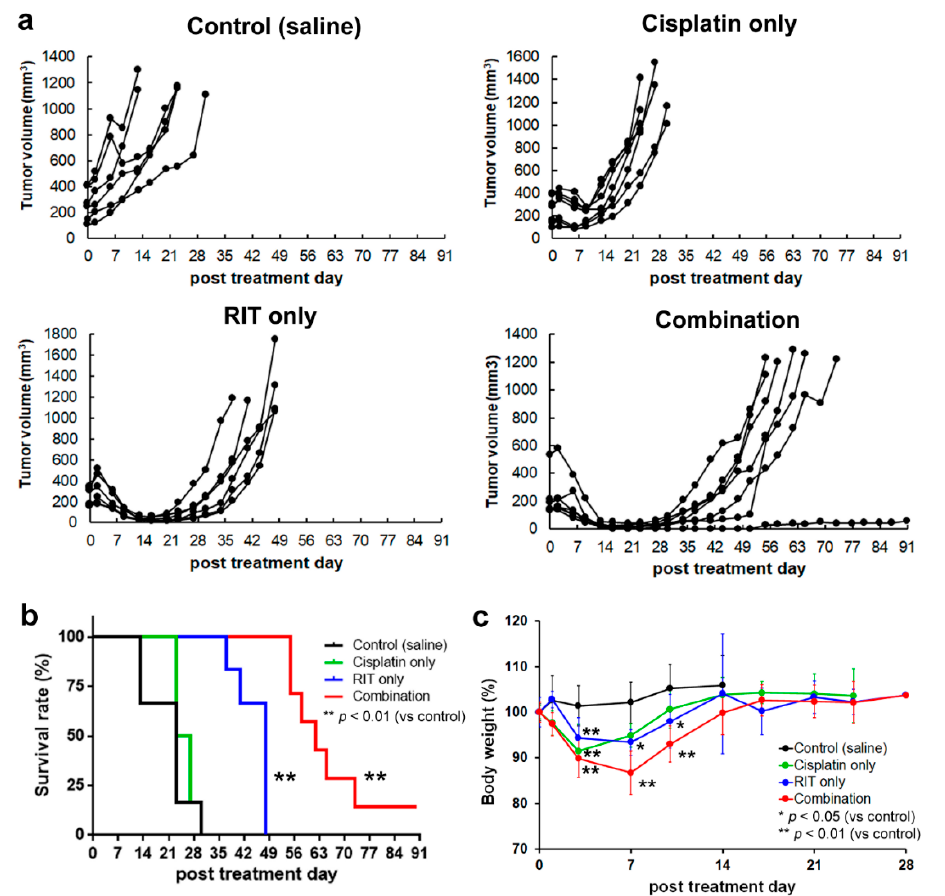
Figure 1. Therapeutic impact and adverse effects observed in distinct treatment groups. ( a ) Change in tumor volume of the control group; ( b ) Kaplan–Meier survival curves; ( c ) Change in body weight. Black represents the control group, green represents the cisplatin-only group, blue represents the radioimmunotherapy (RIT)-only group, and red represents the combination therapy group. * p < 0.05 (vs. control group), ** p < 0.01 (vs. control group).